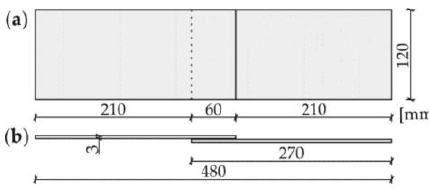
Figure 1. Geometry of the analyzed single lap joint: ( a ) plan view; and, ( b ) side view.